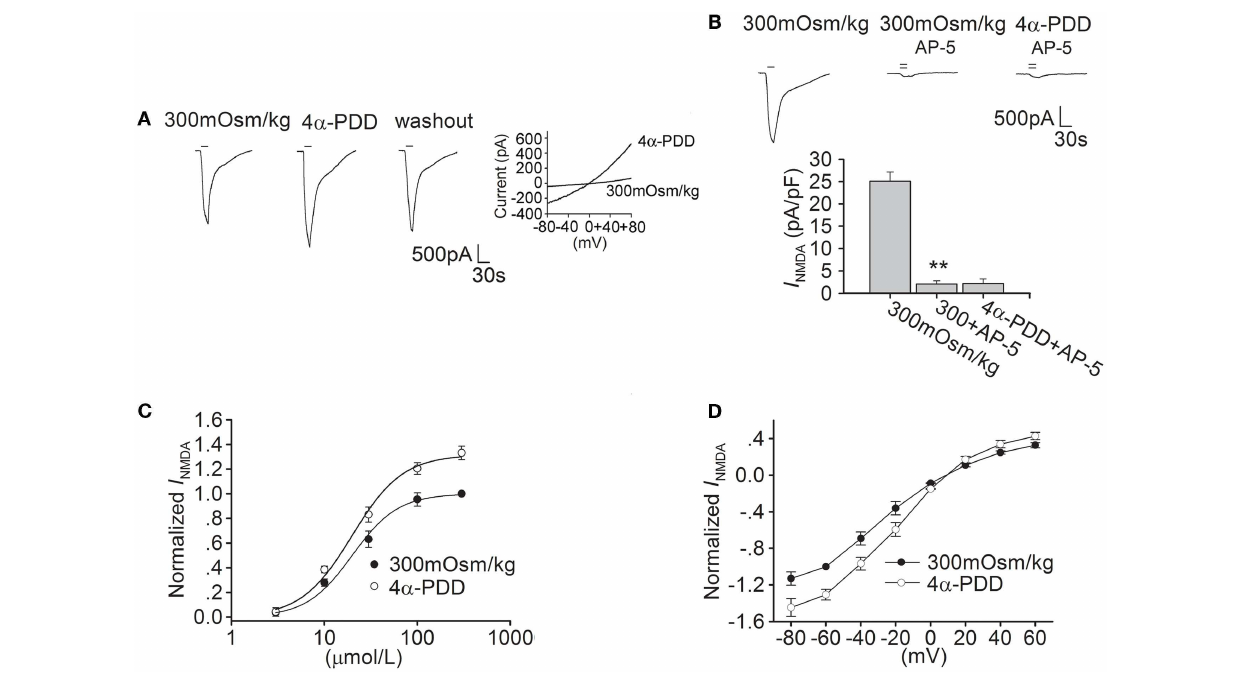
FIGURE 1 | 4 α -PDD increases I NMDA in hippocampal CA1 pyramidal neurons. (A) The typical recordings show that I NMDA was increased from − 1.93 to − 2.52nA after application of 4 α -PDD for 5min and the current recovered to − 2.1nA after washout. 4 α -PDD-evoked current was recorded in the same neuron. (B) I NMDA was reduced from -25.13 ± 2.01 to -2.05 ± 0.77